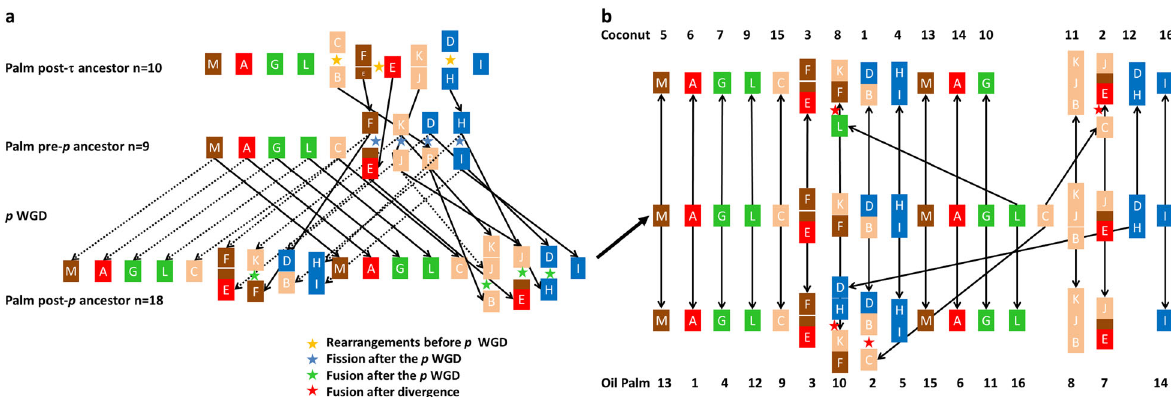
Fig. 5 Hypothetical scenario of palm genome evolution. a From WGD τ to the last common ancestor of coconut and oil palm ( n = 18). The synteny blocks are colored according to their putative origin in the common ancestor of fl owering plants ( n = 5) in Murat et al. 49 . b Divergence of coconut and oil palm from their last common ancestor, resulting in their n = 16 current genomes by two fusions in each species. Table 2 Distribution of coconut genes according to expression pattern during salt stress and annotated to signaling pathways. Putative salt response genes